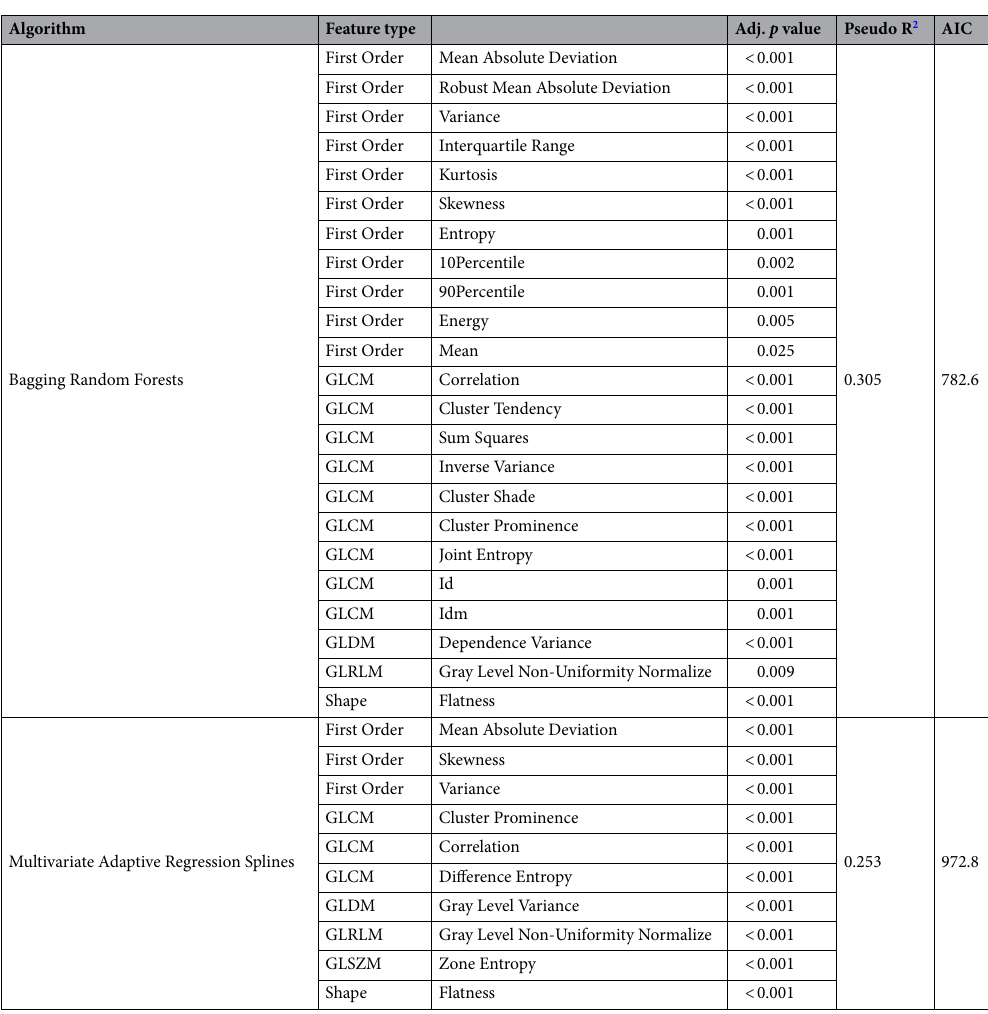
Table 2. Multinomial logistic regression for the selected features by “mnlogit” R package and the model’s fitness indices based on the testing set (N = 332). p value by Wald chi-square test, Adj. p value: P value adjusted by Benjamini and Hochberg method, statistical comparison between two models showed non-significant difference by Likelihood Ratio Test: P value = 0.046, AIC: Akaike information criterion.